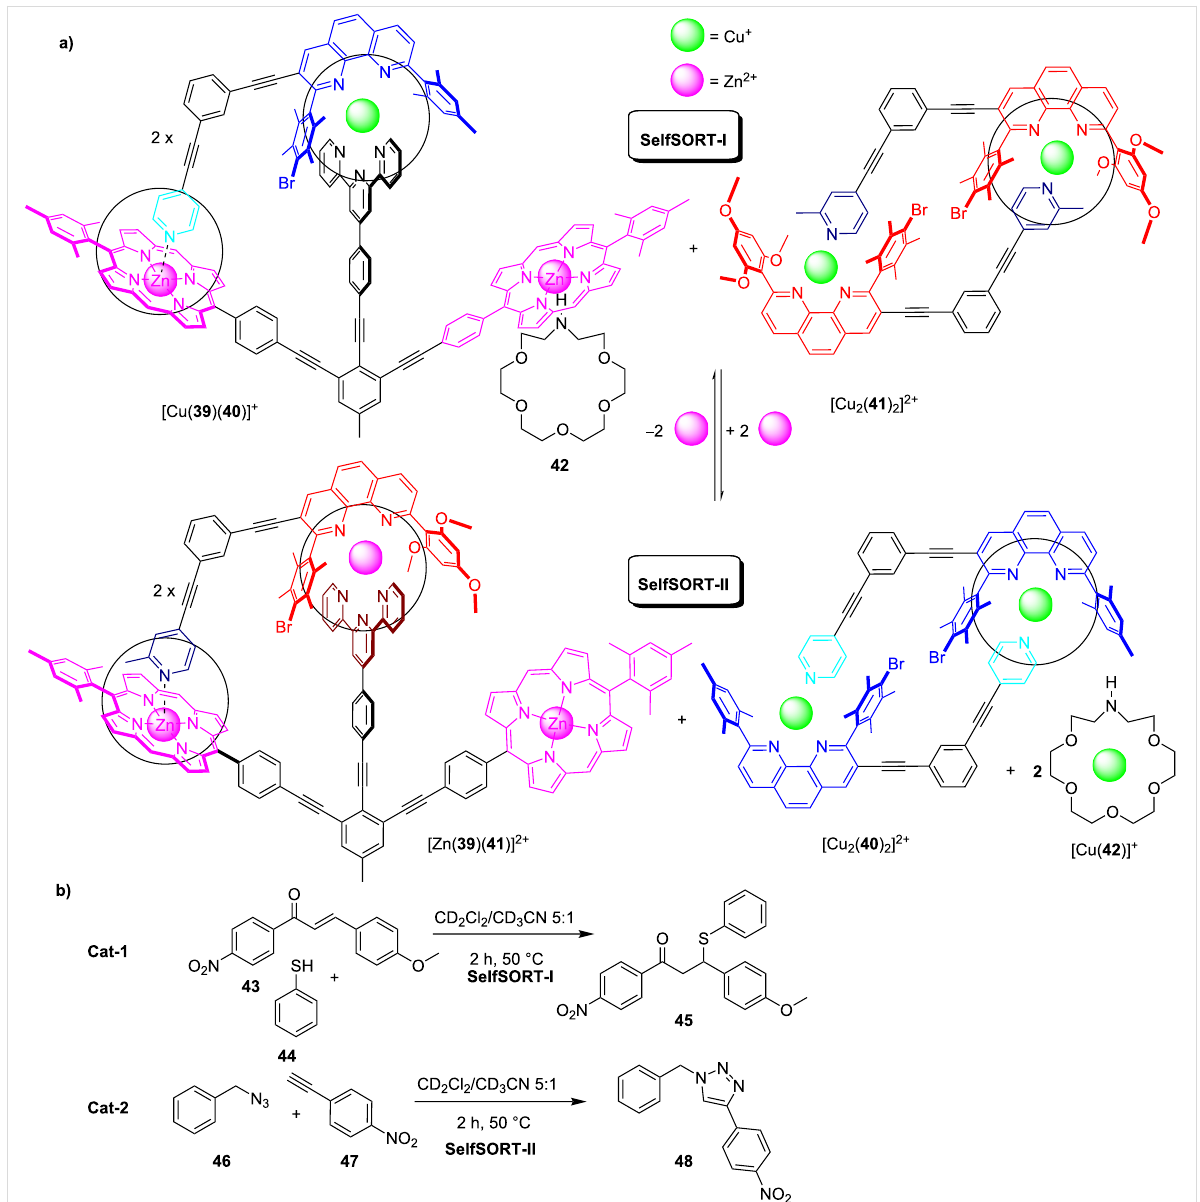
Figure 14: A multicomponent information system for the reversible reconfiguration of switchable dual